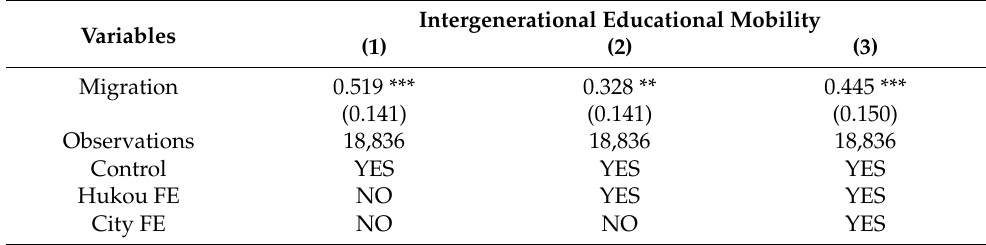
Table 2. Effect of adolescence migration on intergenerational educational mobility.